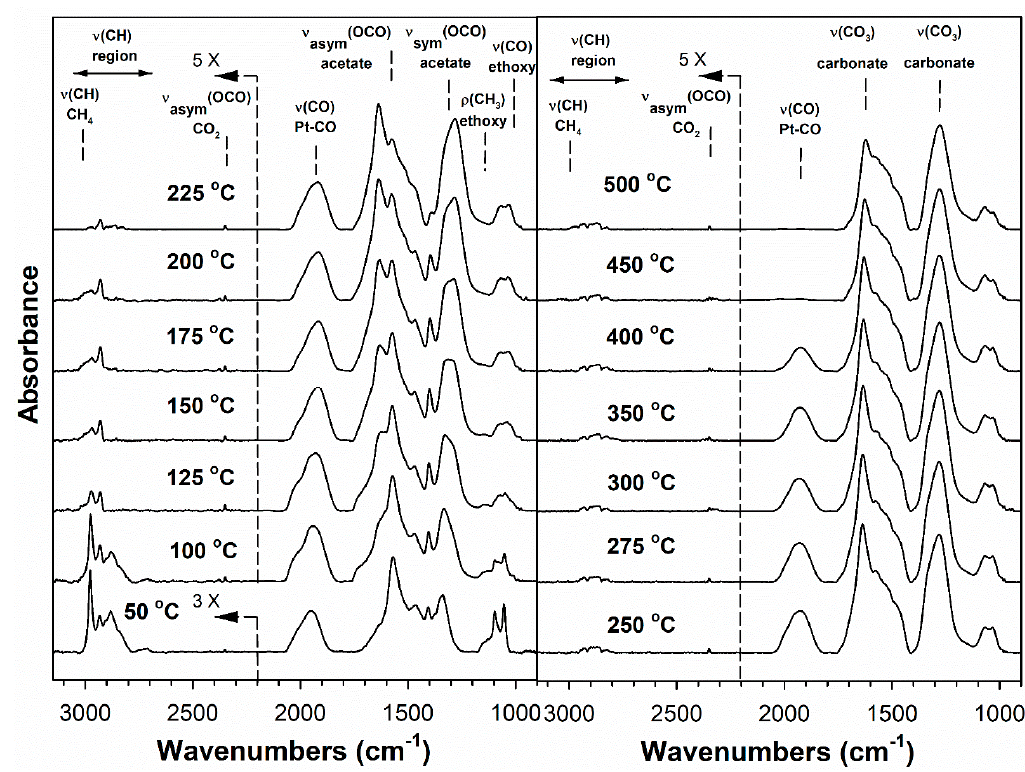
Figure 8. DRIFTS of transient ethanol steam reforming over 5.8% Cs-2% Pt/ZrO 2 .